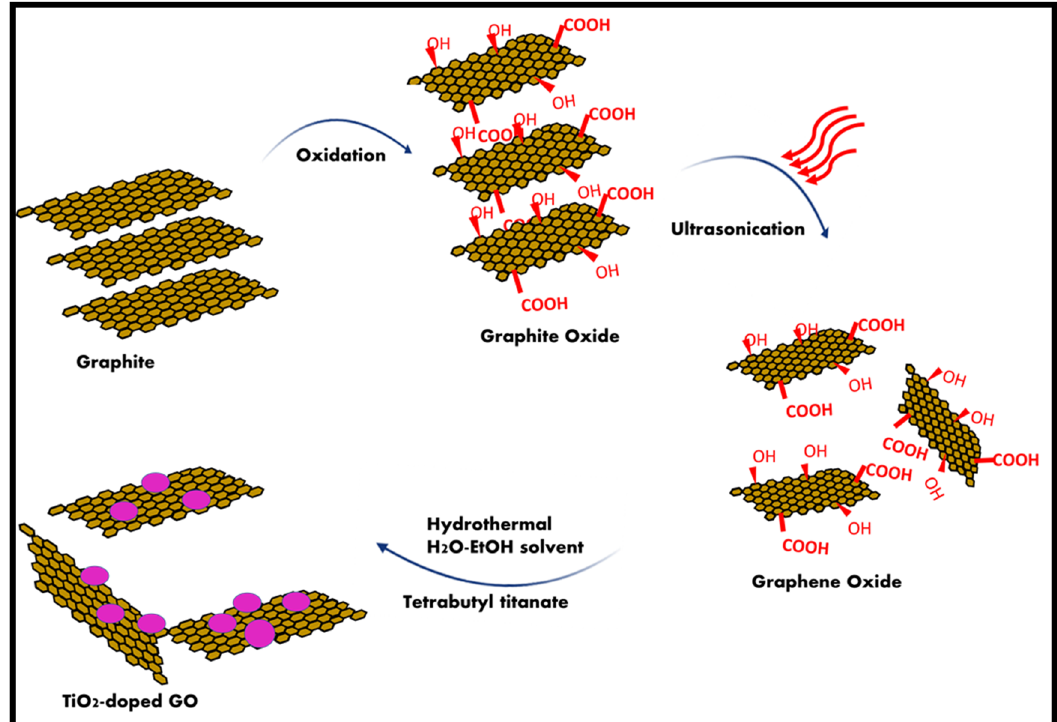
Figure 16: Illustration of the fabrication process of TiO 2 - decorated rGO